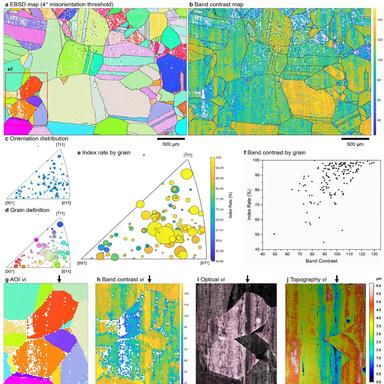
a) Large area (≈8 mm2 ) EBSD map acquired from the single pass surface (20 μm depth from top surface). Grain boundaries identified from >4° of local misorientation (>5 pixels). b) Corresponding band contrast map. c) IPF (z) showing the scatter of data from the map area. Agglomerations are indicative of single grain regions. d) IPF (z), with markers scaled to grain areas. e) IPF (z) (index rate colouring) of the discretised single grain regions, f) slight correlation between grain-isolated band contrast and